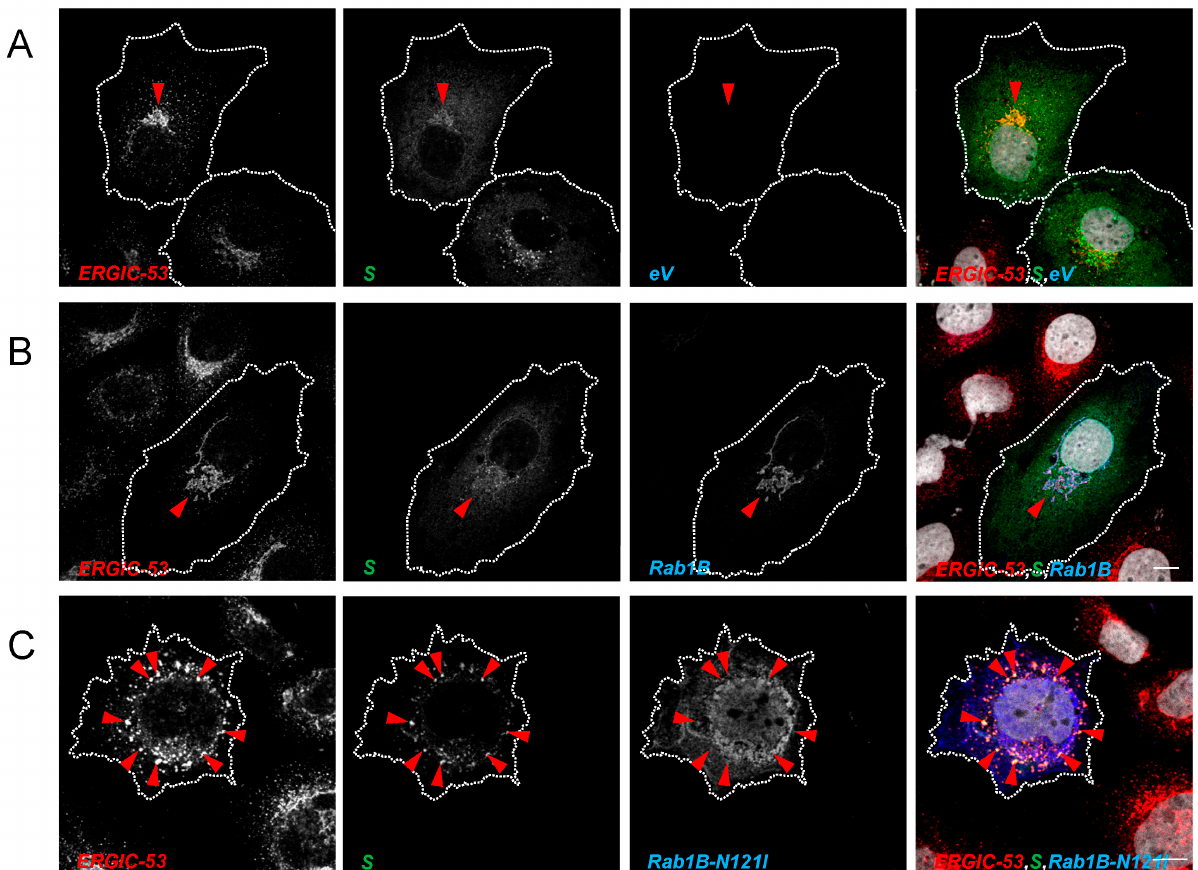
Figure 8. Inhibition of Rab1B traps S protein in the ERGIC. Subconfluent HuH7 cells were transfected with 500 ng pCAGGS-S and 1000 ng ( A ) empty vector (eV) pCAGGS, ( B ) pCMV-Rab1B-myc or ( C ) pCMV-Rab1B-N121I-myc, respectively. Cells were fixed 24 hpt and stained for SARS-CoV-2 S (green), ERGIC-53 (red), Rab1A/Rab1B (anti-myc, blue) and nuclei (grey) with DAPI. Scale bars indicate 10 µ m. Arrows demonstrate colocalization of S and ERGIC-53. Data are representative of two independent